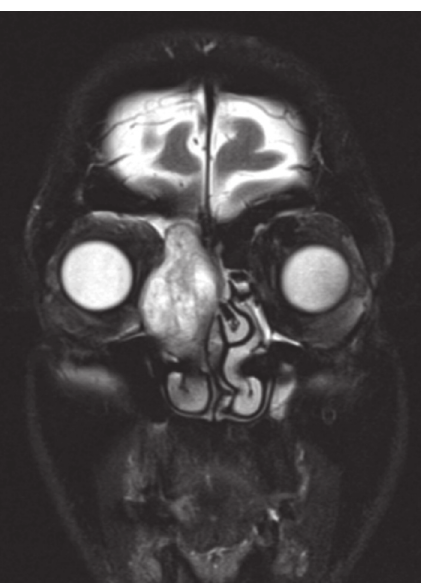
Figure 1: Pre-op MRI scan (coronal plane). Preoperative MRI T2 sequence showing the tumour measuring 40 × 23mm obstructing the frontal sinus drainage pathway with infraorbital extension and bowing of the nasal